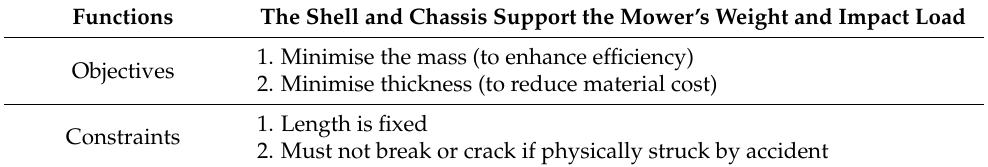
Table 15. Design requirements for lawnmower